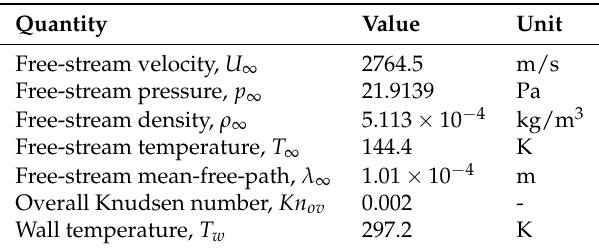
Table 1. Initial conditions for the Mach 11.3 blunted